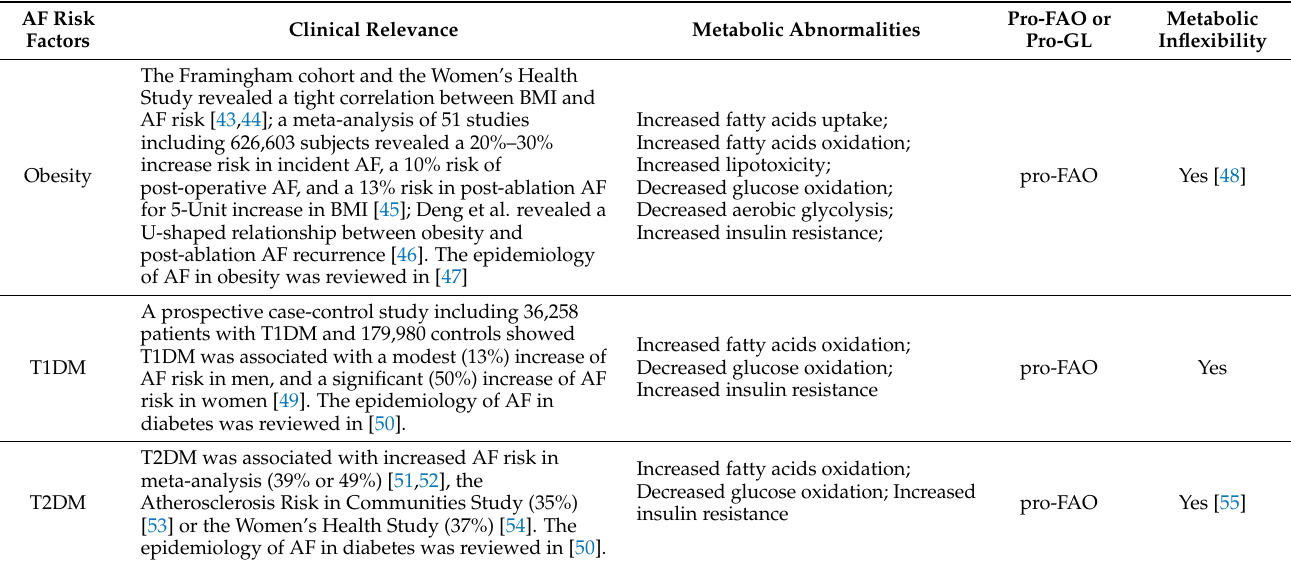
Table 1. Metabolic heterogeneity among AF